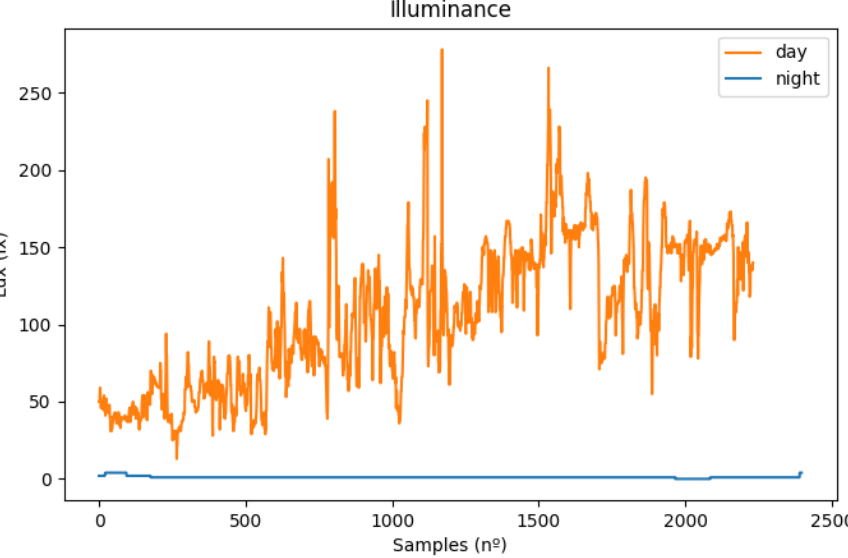
Figure 18. Illuminance values recorded during day hours (orange), and during the night